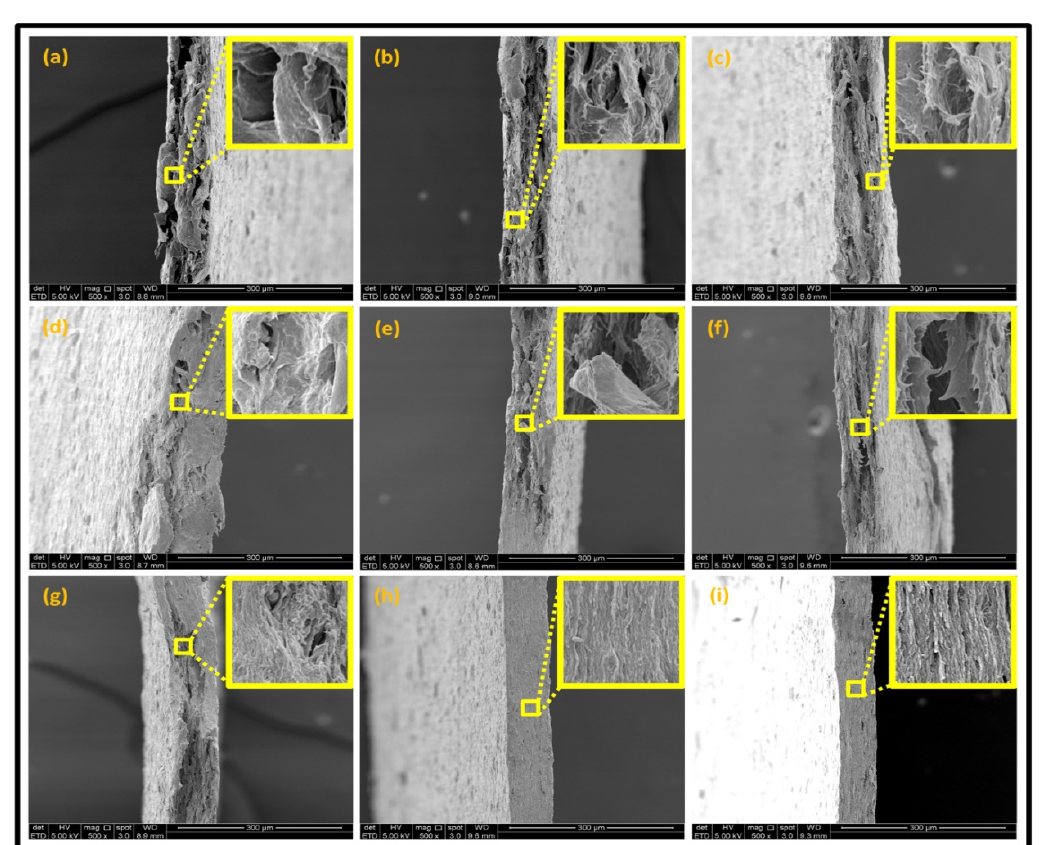
Figure 7. Fracture morphology of ( a ) control film, macroalgae-based biopolymer film with incorporation of unpurified LNPs of ( b ) 1%; ( c ) 3%; ( d ) 5%; and ( e ) 7%, and with addition of purified LNPs of ( f ) 1%; ( g ) 3%; ( h ) 5%; and ( i ) 7%.